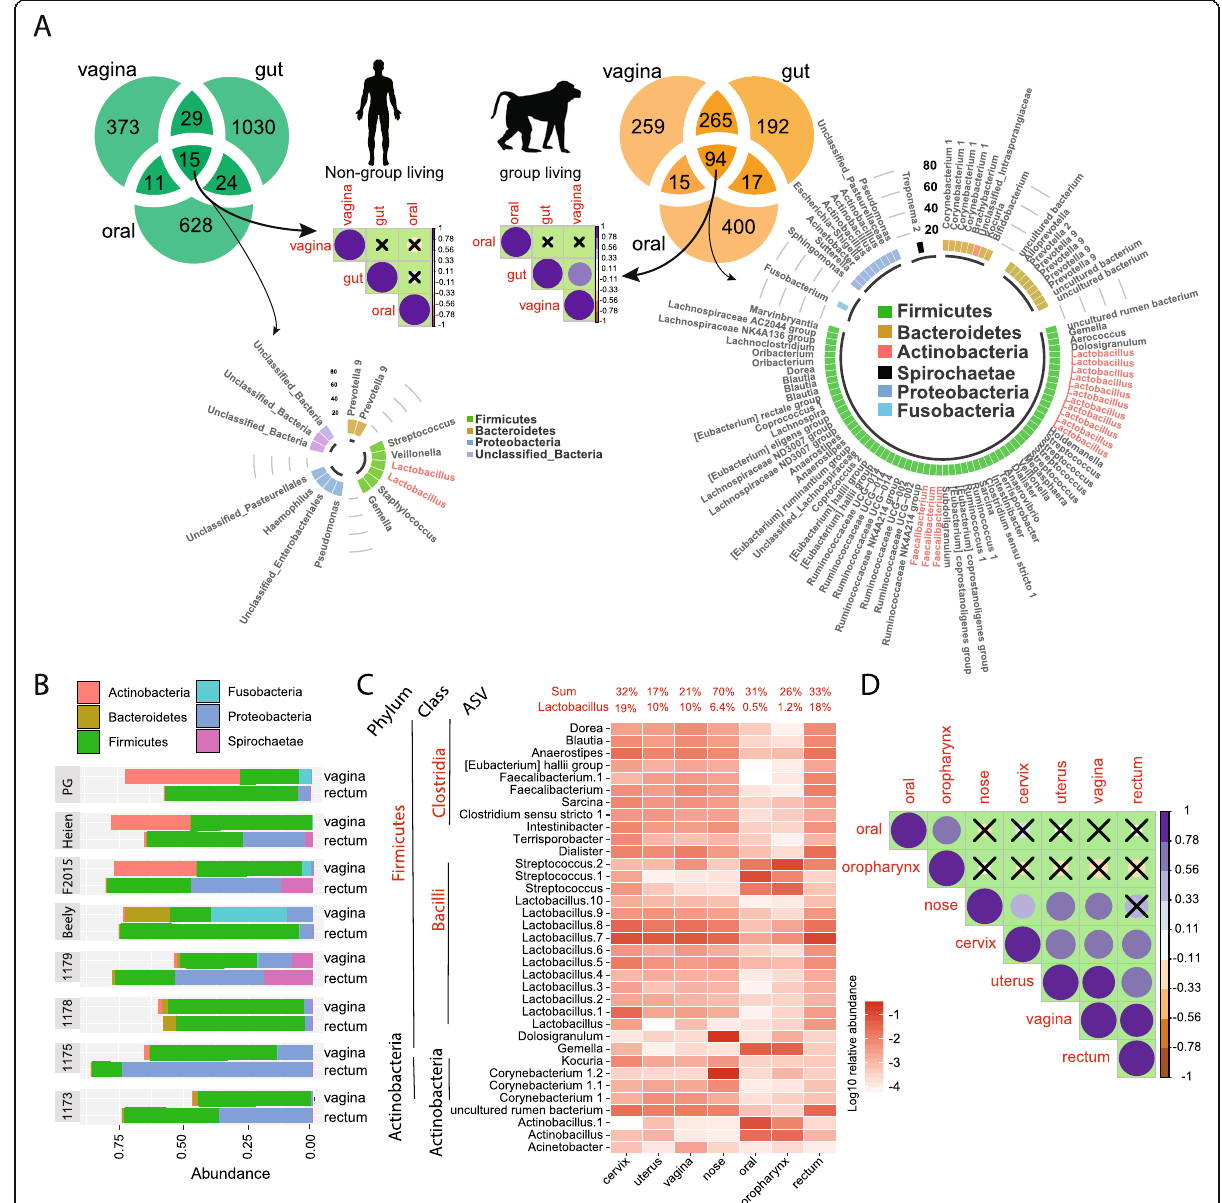
Fig. 4 Shared microbial ASVs and their correlation analysis among human/baboon oral, gut and vagina, and among all seven body sites of baboons. a Venn diagrams showing the number of shared ASVs and spearman correlation matrix for shared ASVs among oral, gut and vagina of humans and baboons. X in the correlation matrix means no significant correlations. All the significant correlations shown in the matrix have an adjusted p -value< 0.01. Color intensity and the size of the circle are proportional to the correlation coefficients. The shared ASVs by human and baboon samples were plotted in the circular barplots. b Bar plots showing the 40 most abundant bacteria ASVs of vagina and rectum in eight baboons. c Heatmap for 35 ASVs shared by all body sites. The ASVs belonging to genus Lactobacillus and Faecalibacterium are marked in red. The relative abundances of Lactobacillus and the 35 ASVs are listed. d Spearman correlation analysis for 35 ASVs shared by seven body sites. Only the Spearman correlation coefficients (PCC) with an adjusted p < 0.01 were plotted. X in the correlation matrix means no significant correlations.